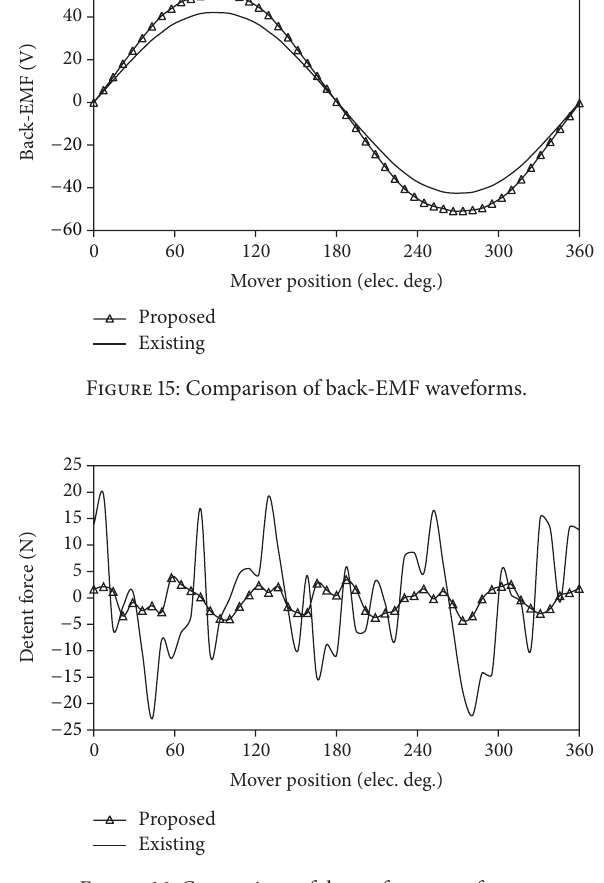
Figure 16: Comparison of detent force waveforms.